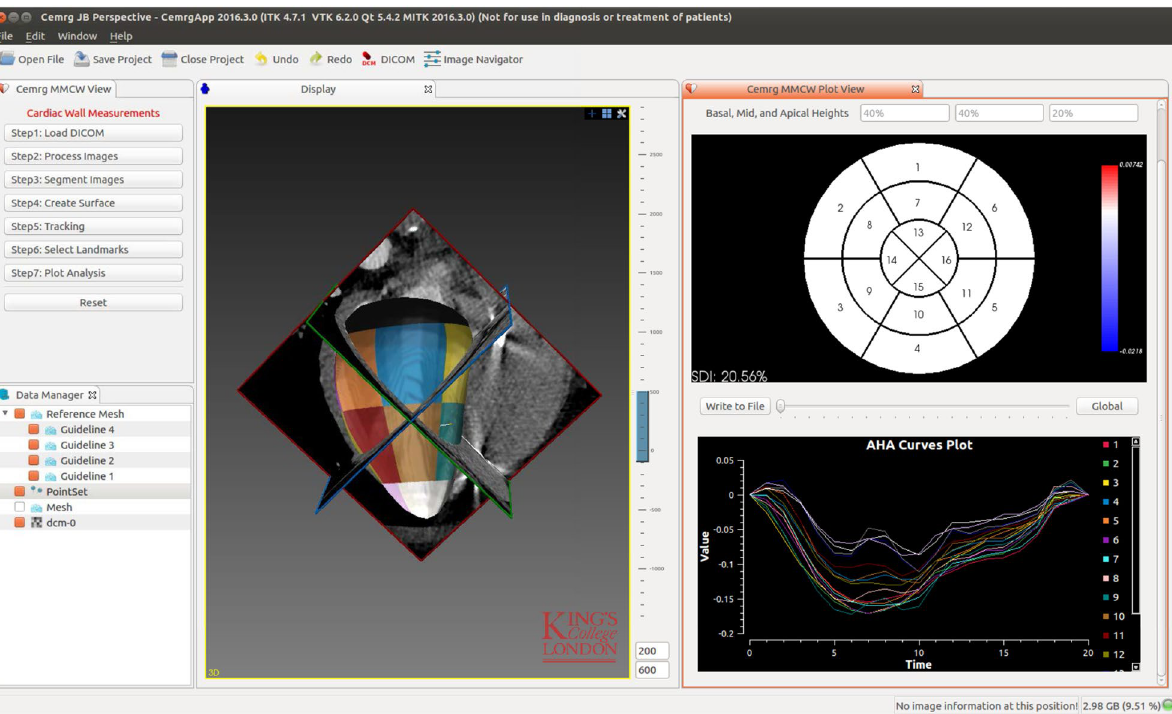
Figure 1. Our platform is based on MITK features and provides a straightforward approach for analysing wall motion from CCT datasets. The window in the top right corner displays a 16-segment bullseye plot for visualisation of strain at every phase in the cardiac cycle. The window in the bottom right corner plots individual strain curves from the endocardial segments. The larger window in the left is an interactive renderer for visualising 3D images and surface